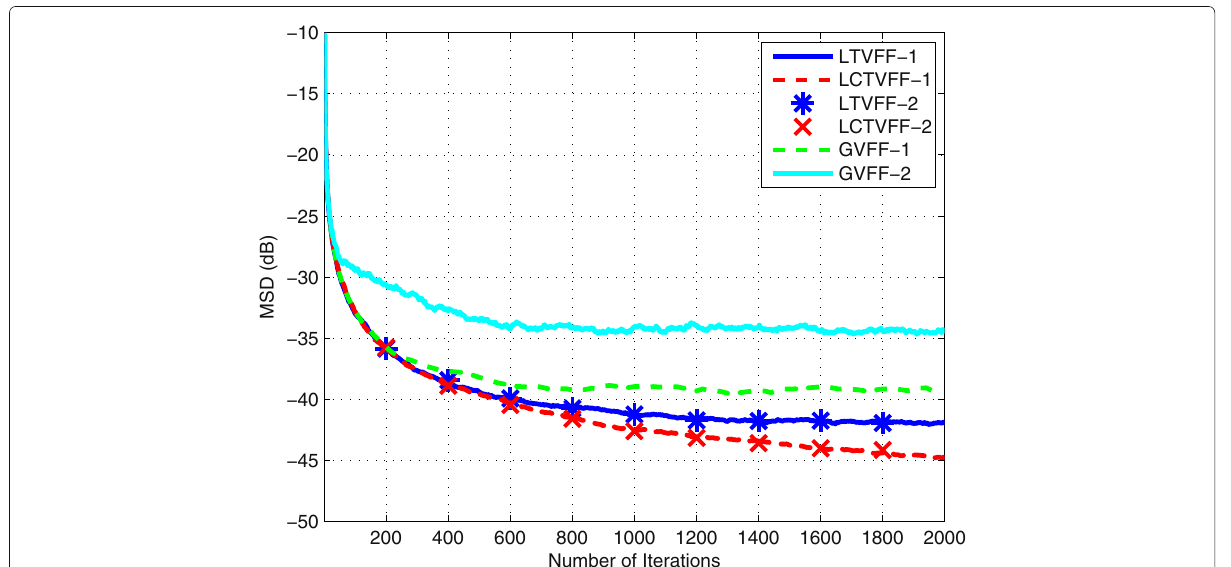
Fig. 9 MSD performance against iterations for the proposed algorithms with different initial values for the forgetting factor compared with the GVFF-DRLS